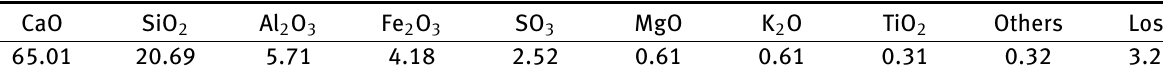
Table 1: Chemical composition of OPC (%).